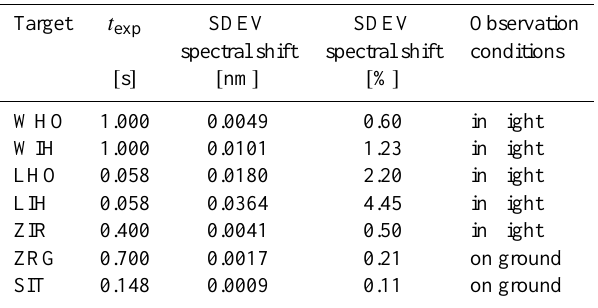
Table 6. MAMAP SWIR relative single readout detector spectral stability (readout to readout) as retrieved by best estimate of the WFMD/M algorithm for different reference targets for a slit func- tion FWHM of 0.82nm for different dynamic in flight and static on ground measurements. The different stability values are not di- rectly comparable because of different exposure times during the measurements. Comparison of the shift values for different condi- tions give only a raw estimate for short time spectral shifts caused by vibrations and short time spectral shifts caused by inhomoge- neous illumination of the slit induced by keystone and smile effects of the